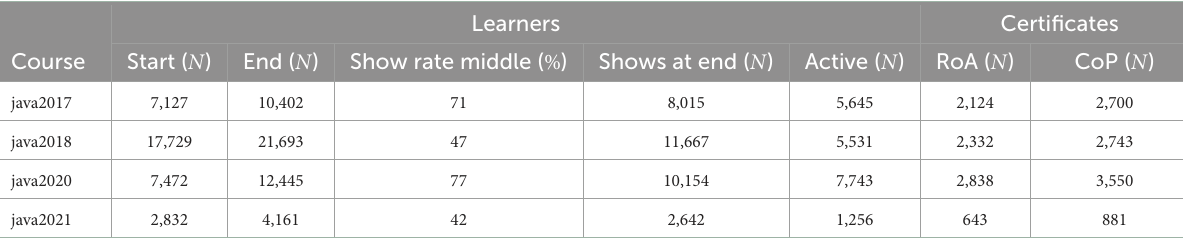
TABLE 2 Overview over course enrollments, active users, and certificates of the three observed Java OOP Programming MOOC iterations until the end of the course period (Hagedorn et al., 2022). Learners Certificates